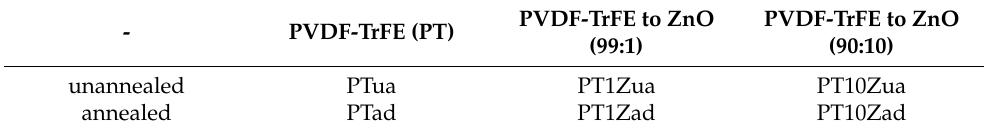
Table 1. Abbreviations for eight comparison groups in the